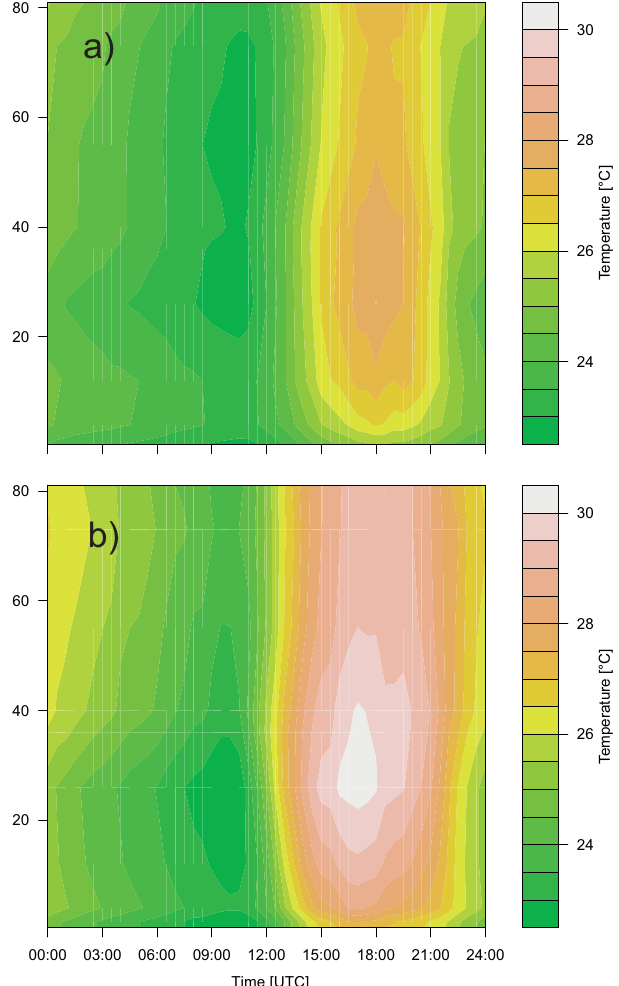
Figure 8. Diurnal profiles of temperature for (a) wet season (March 2014) and (b) dry season (September 2013). Contour plots interpo- lated from measurements at 0.4, 1.5, 4, 12, 26, 36, 40, 55, 73, and